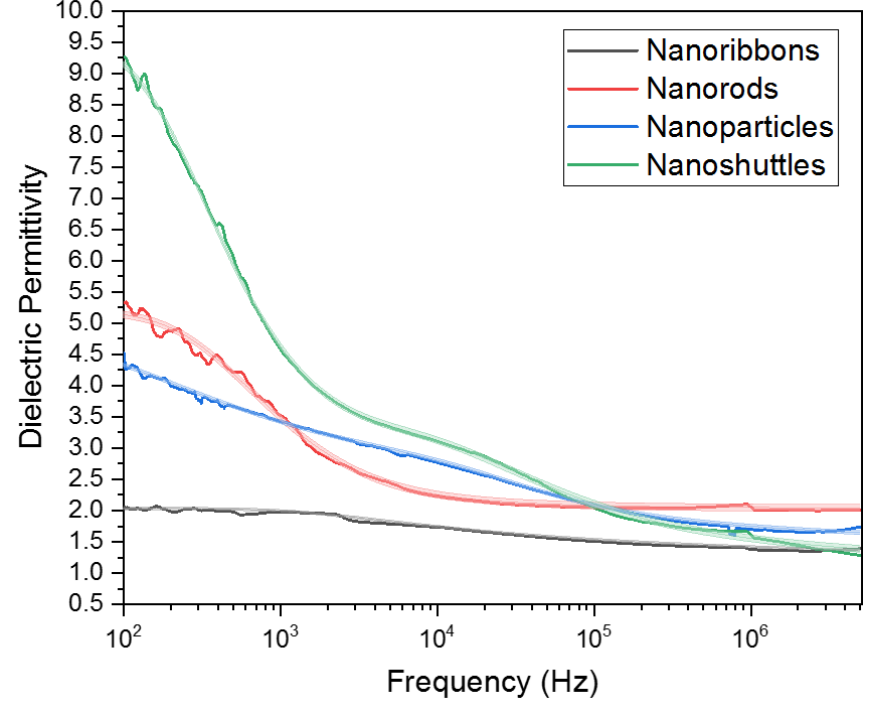
Figure 10. Dielectric spectra of ZnO nanostructures.